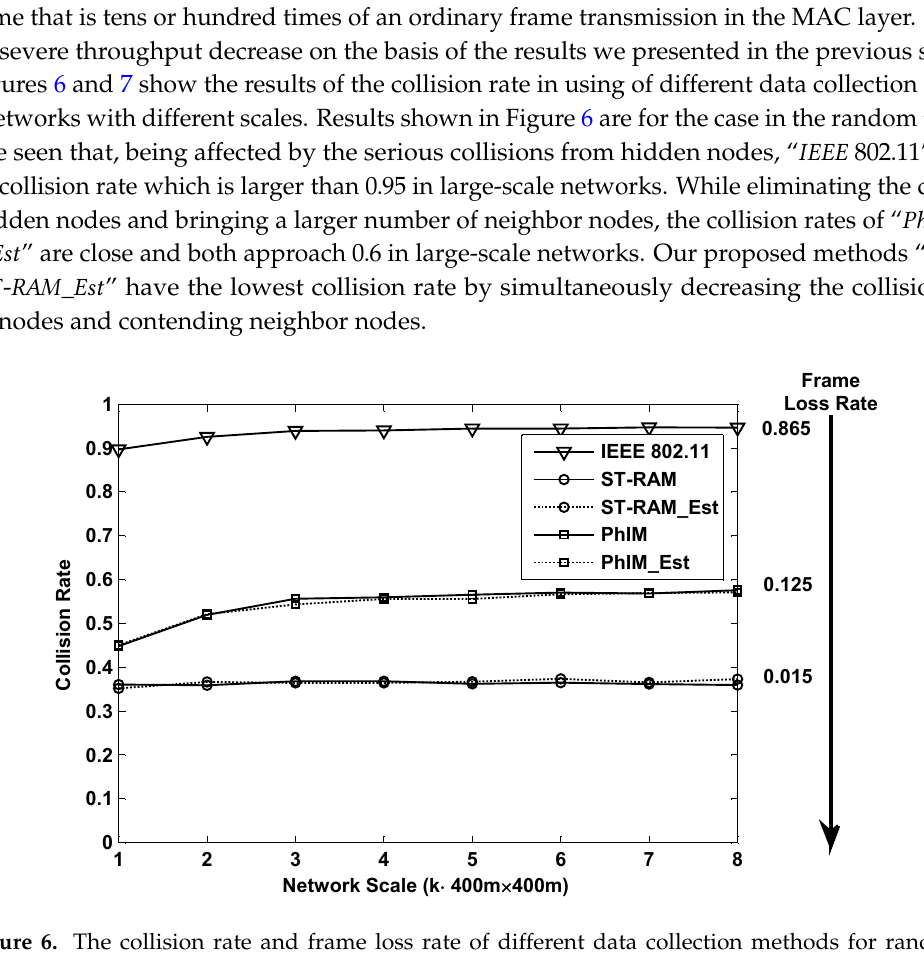
Figure 6. The collision rate and frame loss rate of different data collection methods for random deployed networks with different